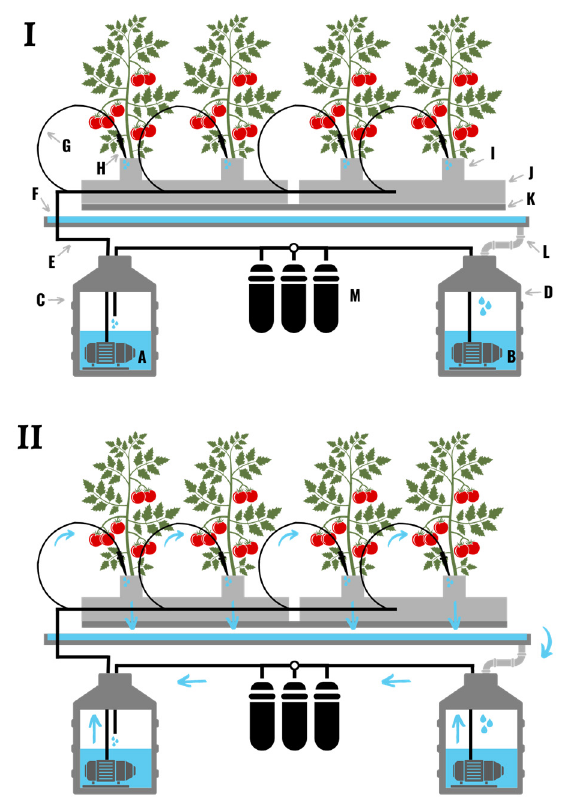
Figure 4. ( I ) A drip irrigation system comprised of water pumps ( A , B ), two reservoirs ( C , D ), a wa- tering line/pipe ( E ), a drain trough ( F ), drip lines ( G ), drip stakes ( H ), a smaller grow media